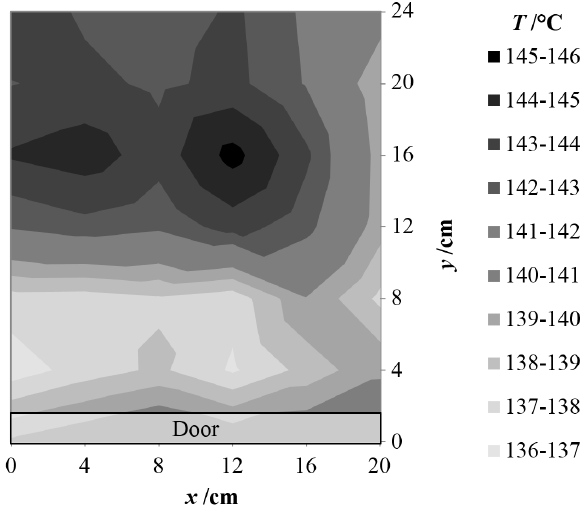
Figure 6. Temperature distribution in cross-linking oven after in- serting the coated TSRs.